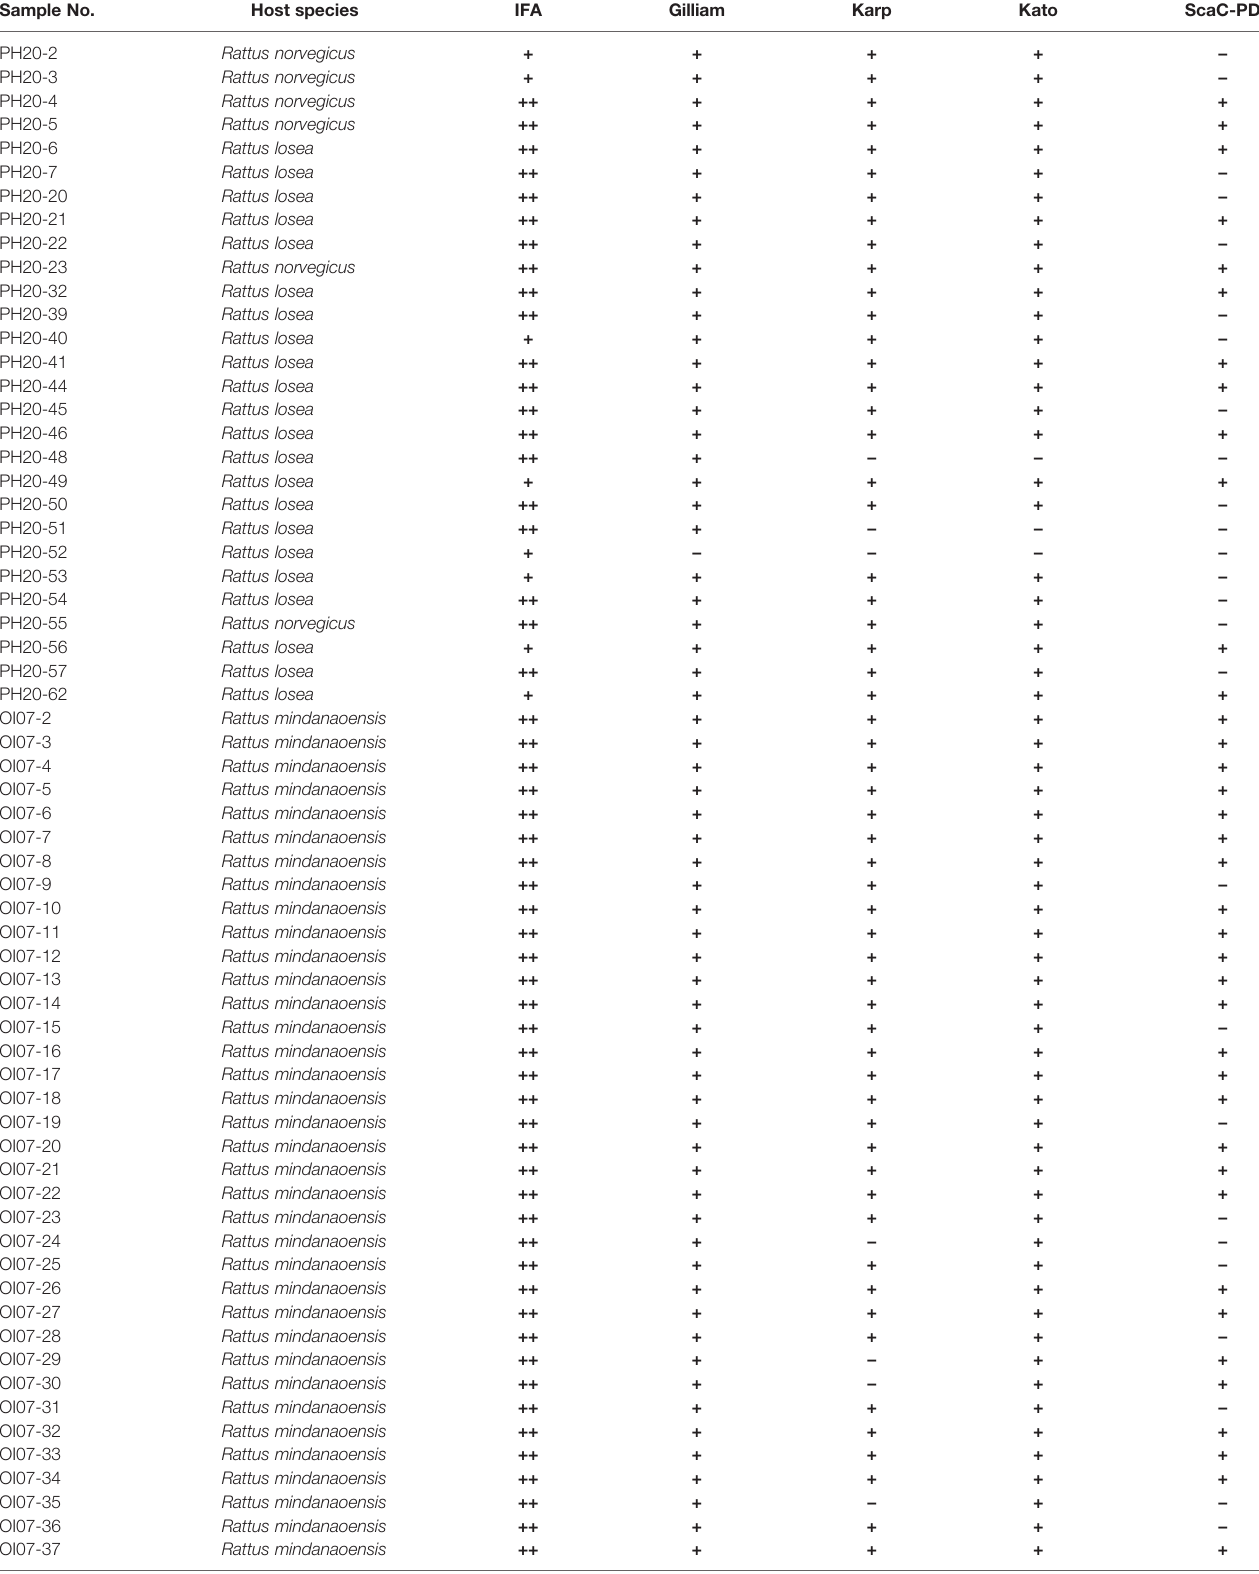
TABLE 2 | Diagnostic results for each rat serum sample upon reaction with individual antigens in the cell-based ELISA. Sample